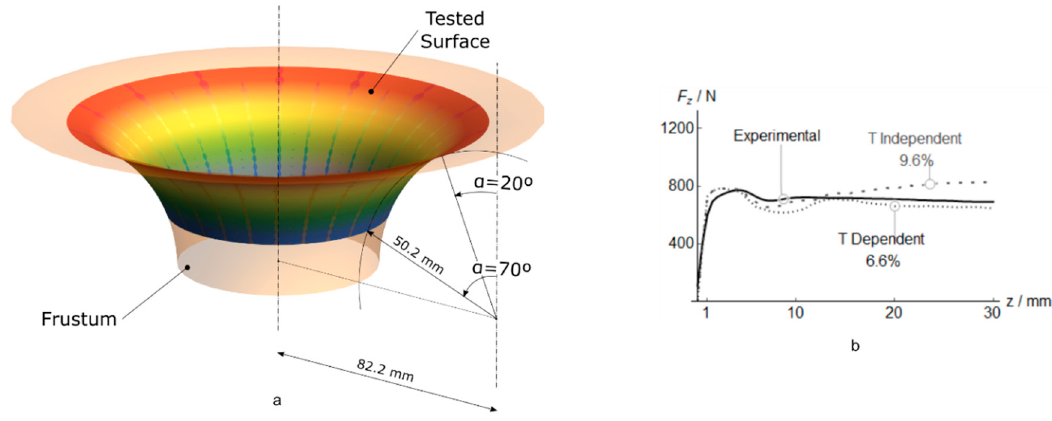
Figure 14. Representation of the Frustum ( a ), Experimental vs. predicted mean F z values and estimation error e of temperature-dependent and temperature-independent models for PVC during Frustum forming ( b ).